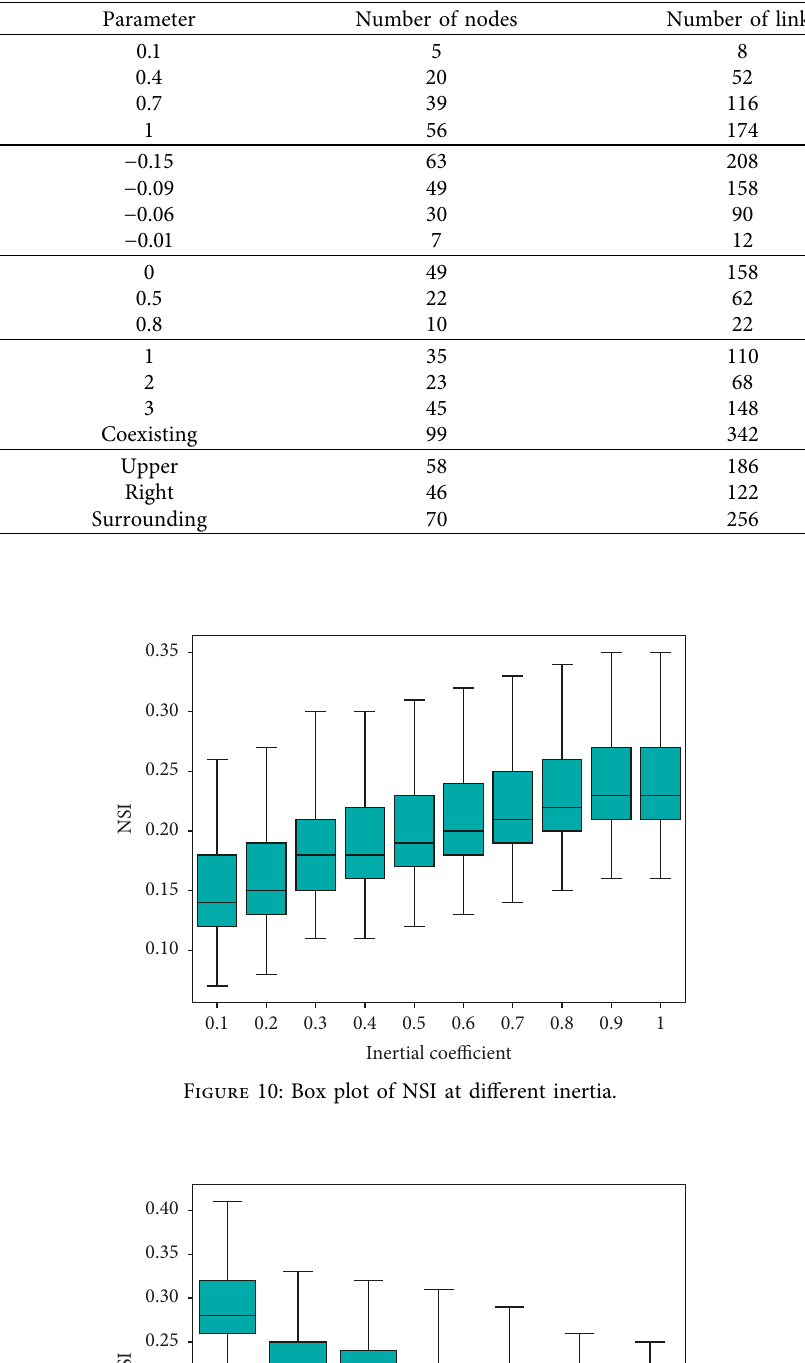
Table 4: Subnetwork constitution under different parameters.